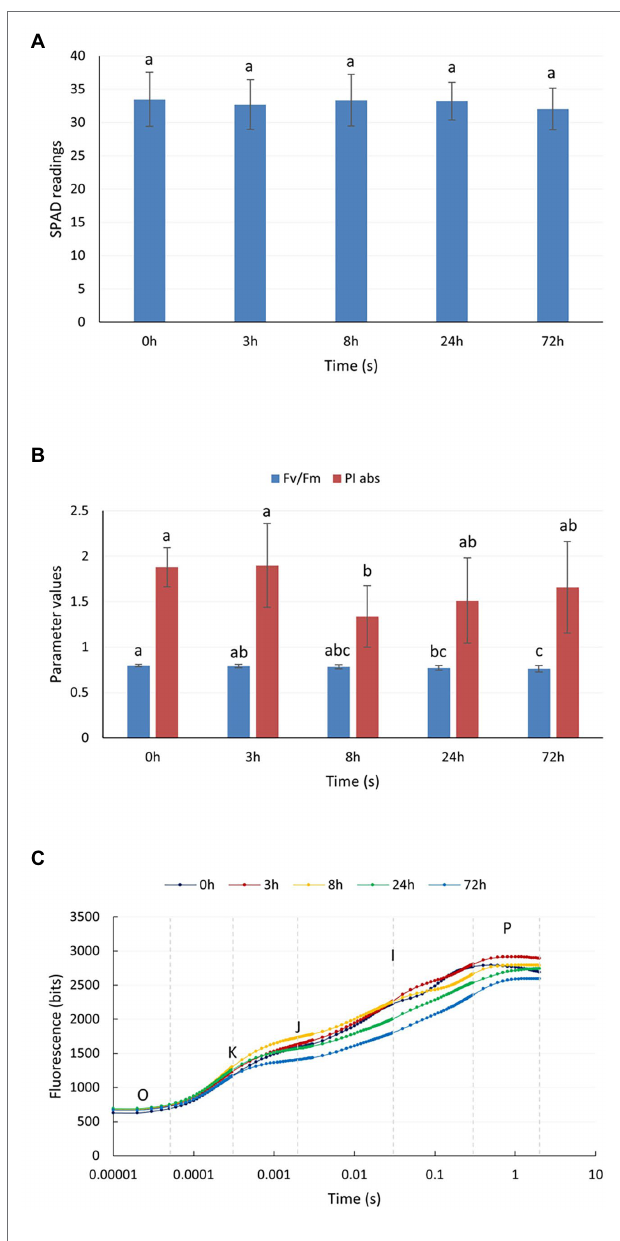
FIGURE 1 | Chlorophyll content and chlorophyll fluorescence parameters of P. auriculata after different cold stress treatment times. (A) Relative chlorophyll content. (B) Chlorophyll fluorescence parameters. (C) Fast chlorophyll fluorescence induction curve. O, K, J, I, and P are the characteristic sites of the chlorophyll fluorescence induction curve. Means with the same letters are non-significantly different at different